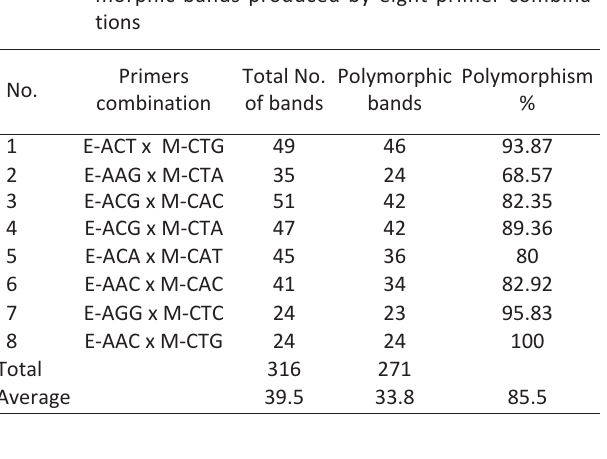
Table 5 - Percent polymorphism, band numbers and